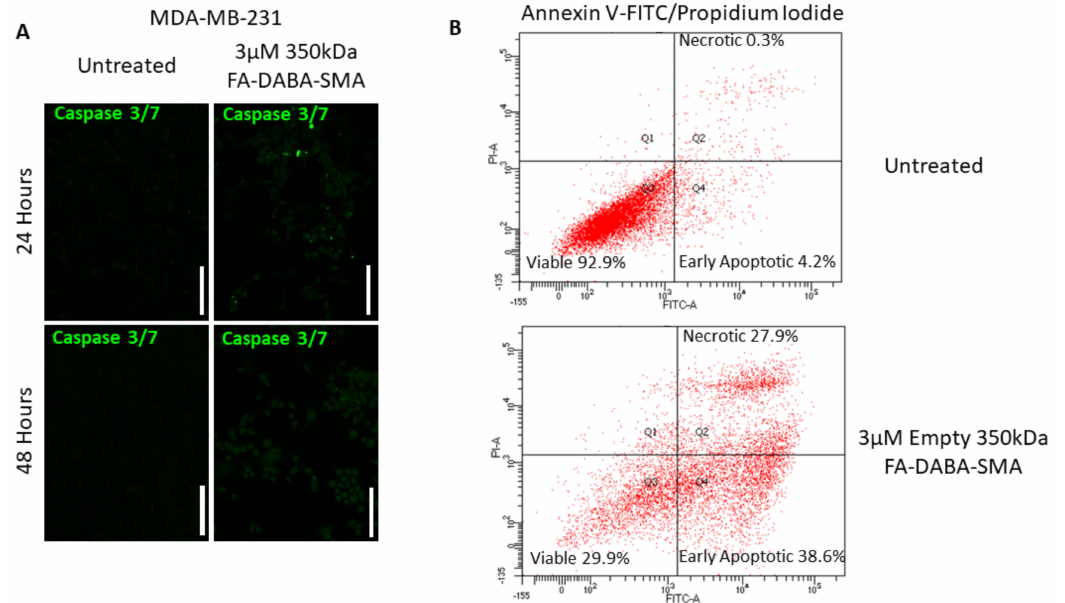
Figure 8. Caspase 3 / 7 and Annexin-V apoptotic activity post-treatment with 350 kDa FA-DABA-SMA on MDA-MB-231 breast cancer cells. ( A ) Immunocytochemistry staining for caspase on the MDA MB-231 cell line before and after 24 and 48 hours of FA-DABA-SMA (350 kDa) treatment. The white scale bar represents 100 µ m, and pictures were taken at 400 × magnification. Green staining is caspase expression. ( B ) Flow cytometry of Annexin-V apoptosis assay of untreated MDA-MB-231 cells or 48 hours after treatment with 3 µ M FA-DABA-SMA (350 kDa). An estimate of ~250,000 cells was collected and stained with Annexin V-FITC / propidium iodide to assess the stage of